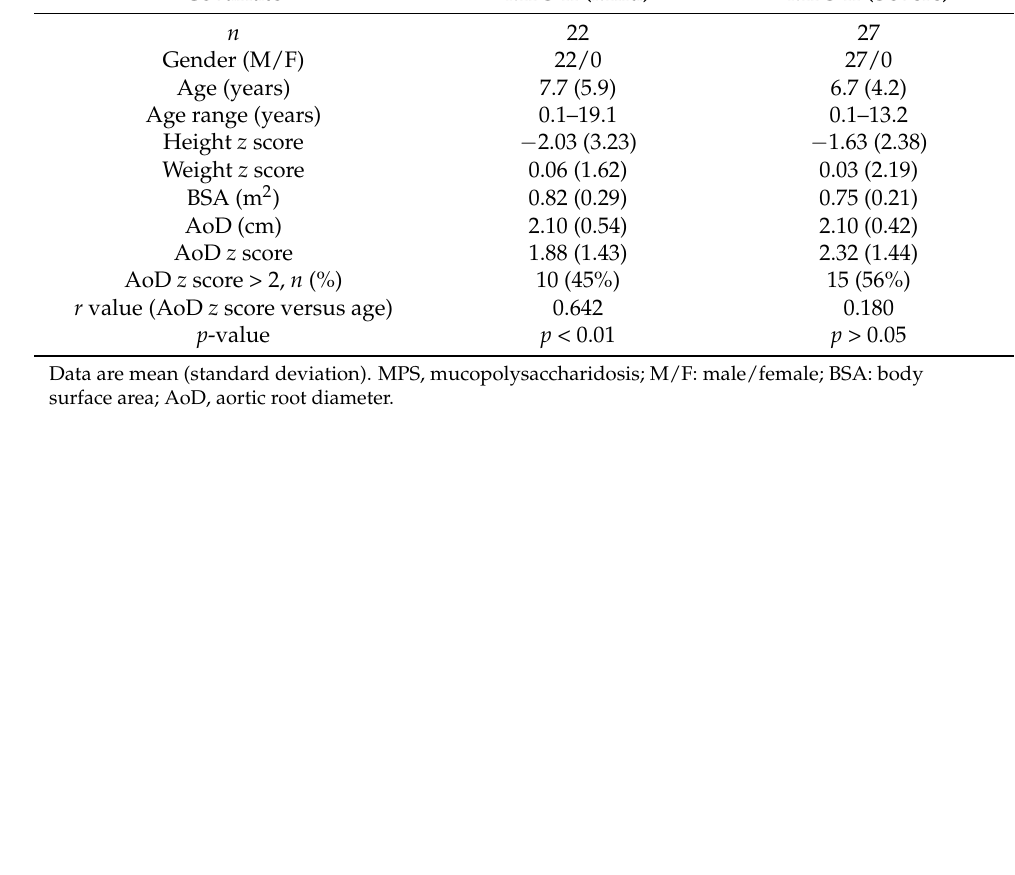
Figure 5. The relationships between aortic root diameter z score and age in the patients with the